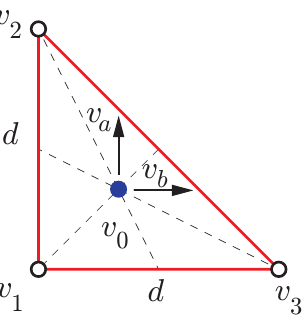
Figure 1. Optimal antenna configuration with three receivers.